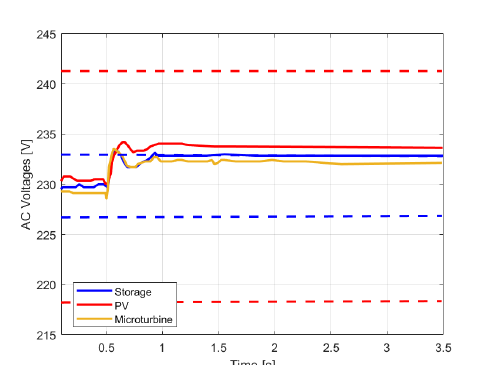
Figure 16. Simulation D: Active Power.